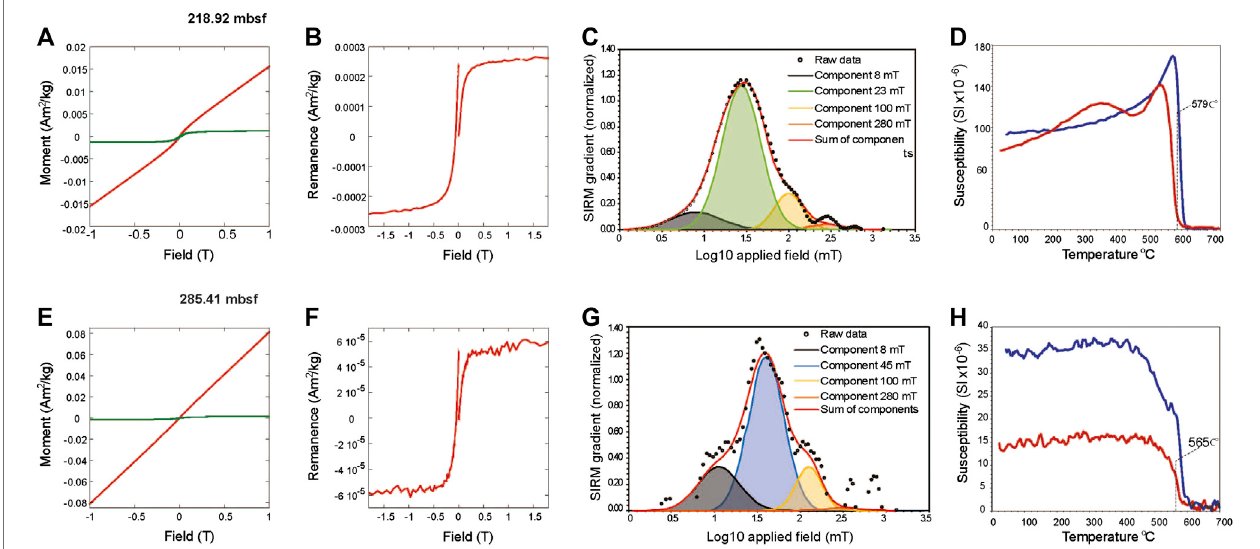
FIGURE3| Rockmagneticpropertiesoftwoselectedsamplesat. (A) , (E) hysteresisloopsbefore(red)andafter(green)subtractingtheparamagneticcontribution, by applying an automatic linear slope correction. (B) , (F) back fi eld and IRM saturaton acquisitions. (C) , (G) IRM acquisition curves gradient with the separated components. Black component: low coercivity detrital magnetite, blue and green components: SD magnetite; orange components: hematite. (C) , (F) thermomagnetic curves, the red curve represents the heating portion and the blue line the cooling portion of the cycle.